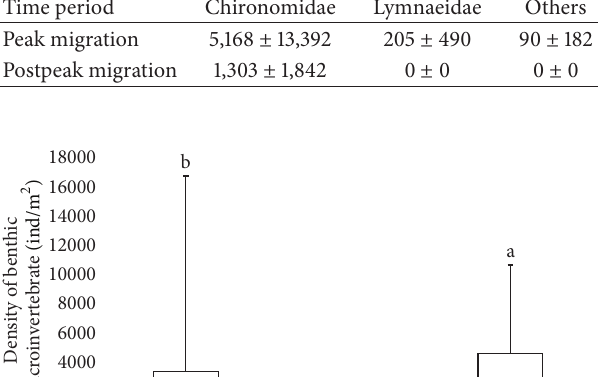
having the highest density and XHZ the lowest (Figure